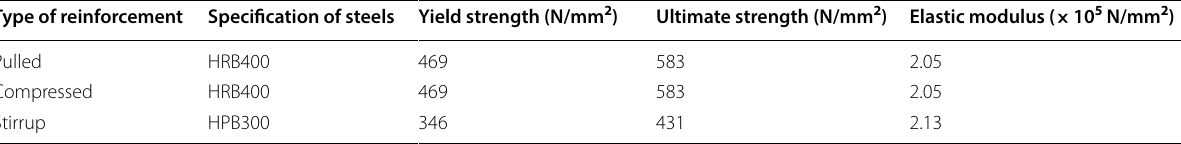
Table 2 Basic parameters of the reinforcement Type of reinforcement Specification of steels Yield strength (N/mm 2 )